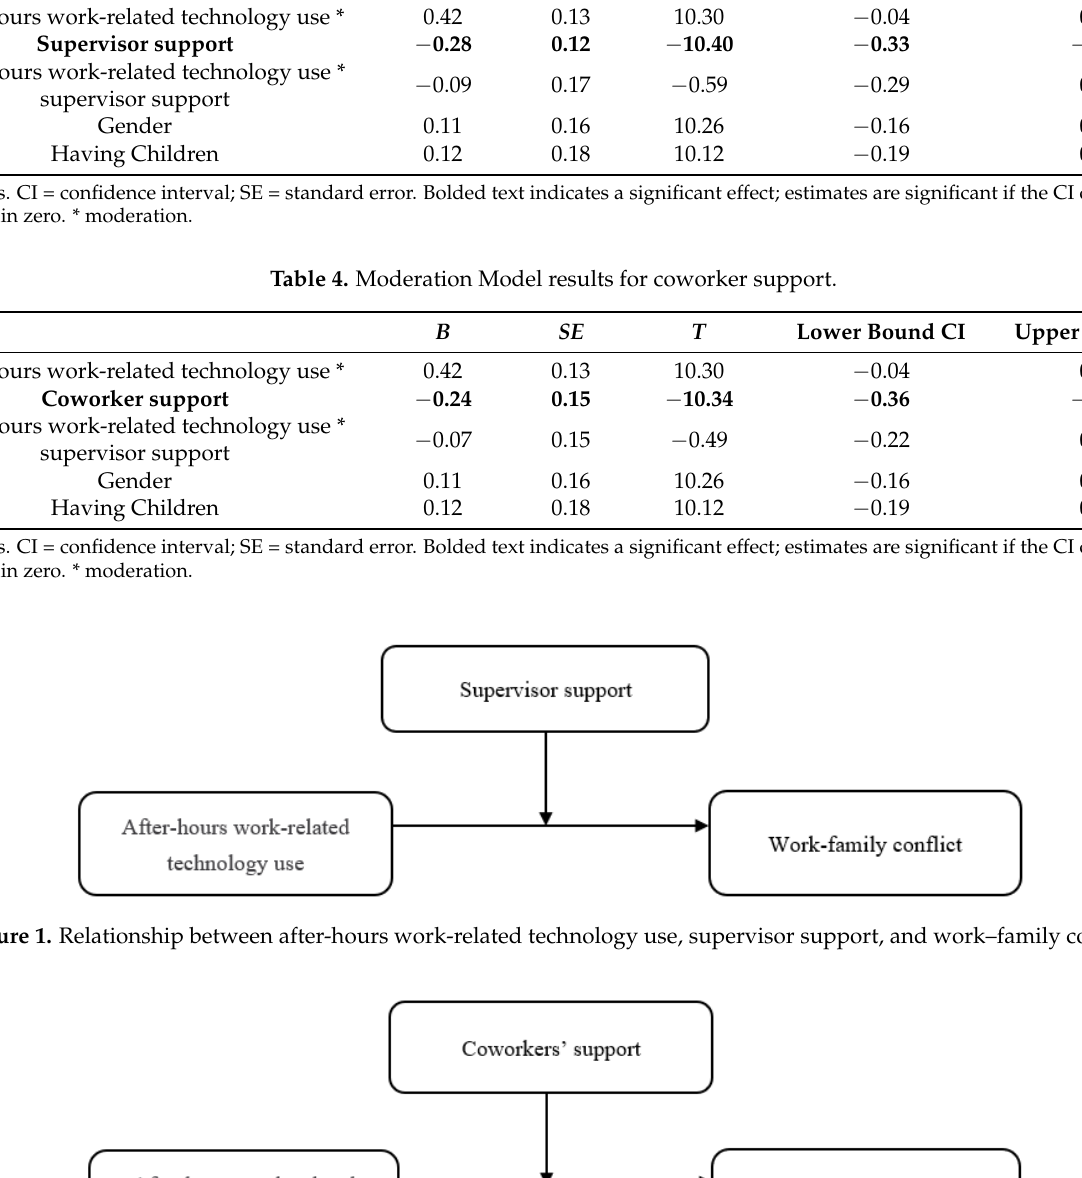
Table 3. Moderation Model results for supervisor support.